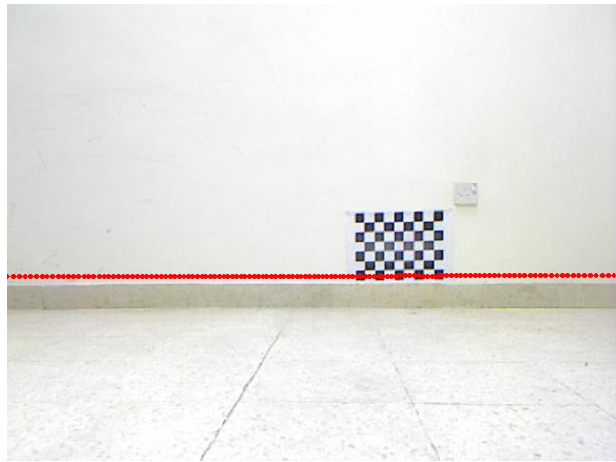
Figure 14. Configuration 4: The projection of the range data to a test image using the estimated Z matrix (points are shown in red color).